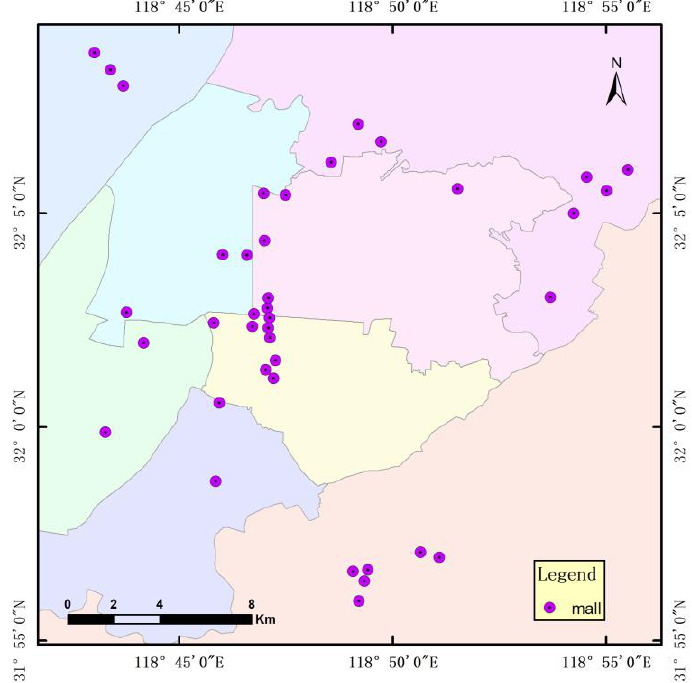
Figure 1. Data distribution map of shopping malls in Nanjing.